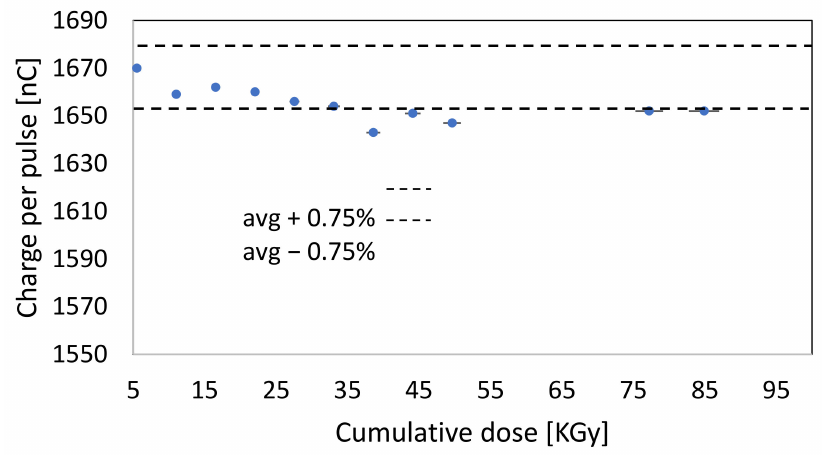
Figure 6. Charge per pulse measured with the SiC detector after each irradiation as a function of the cumulative dose. The dotted lines delimit the region within the ± 0.75% variation in